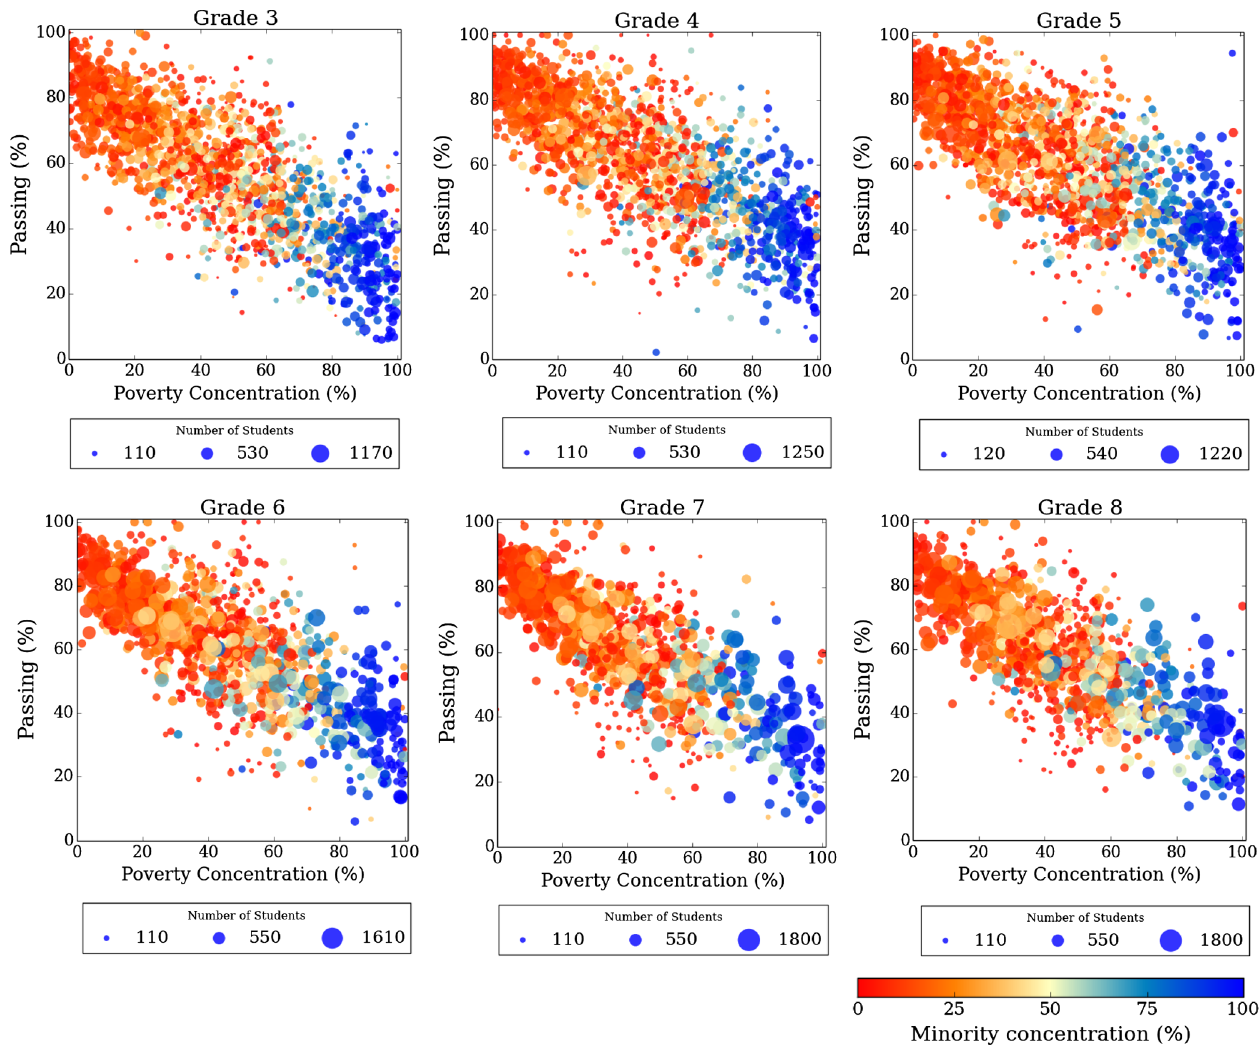
FIG. 3. Illinois school performance, excluding Chicago schools, on the 2013 Math ISAT at grades 3 through 8. The area of each point represents the total number of students tested at each school, and the color represents the percentage of minority students in the school. Performance declines with increasing poverty